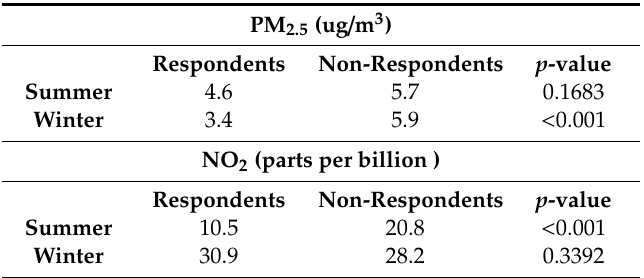
Table 2. Average weekly PM 2.5 and NO 2 concentrations by season for the respondents and